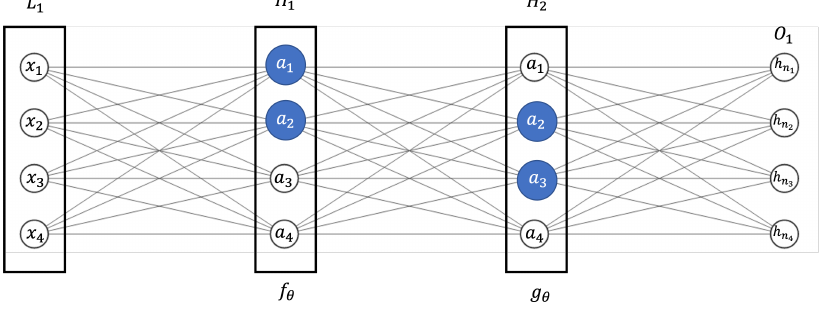
Figure 5. SAE architecture. The SAE-type AE network can work with input and output copies in conjunction with supervised or unsupervised targets. Here the highlighted a 1 , . . . , a k neurons represent those activated in the hidden